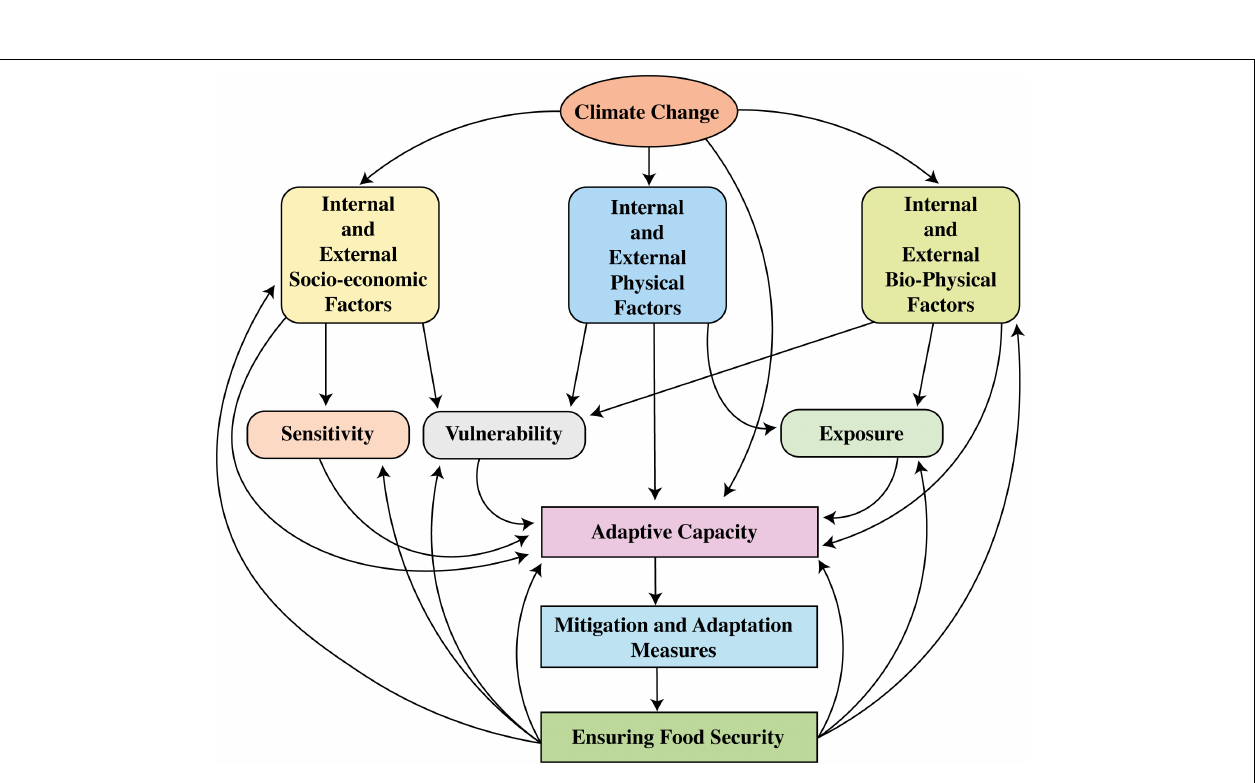
FIGURE 6 | Adaptation and mitigation measures to ensure food